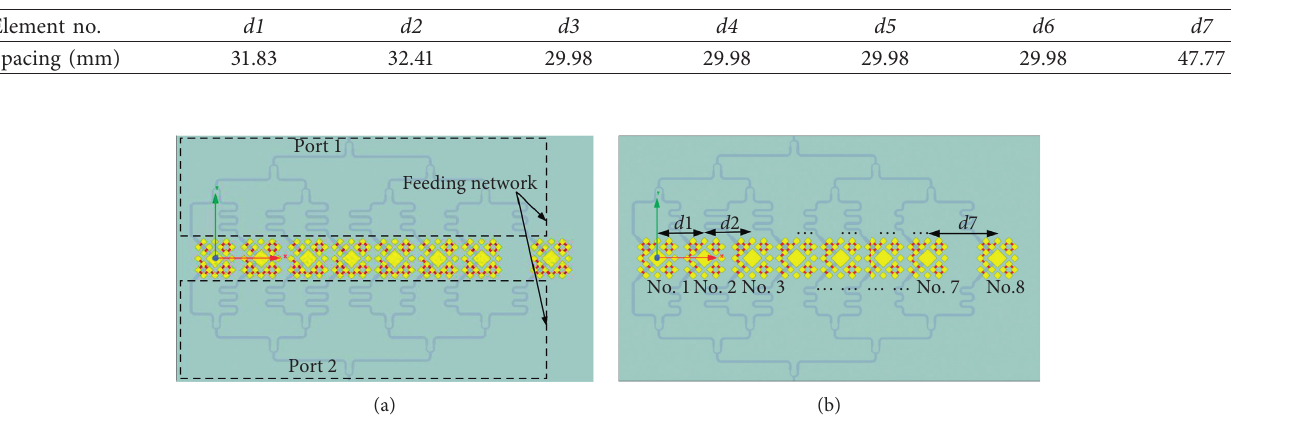
Table 2: Element spacing of the RPA array.